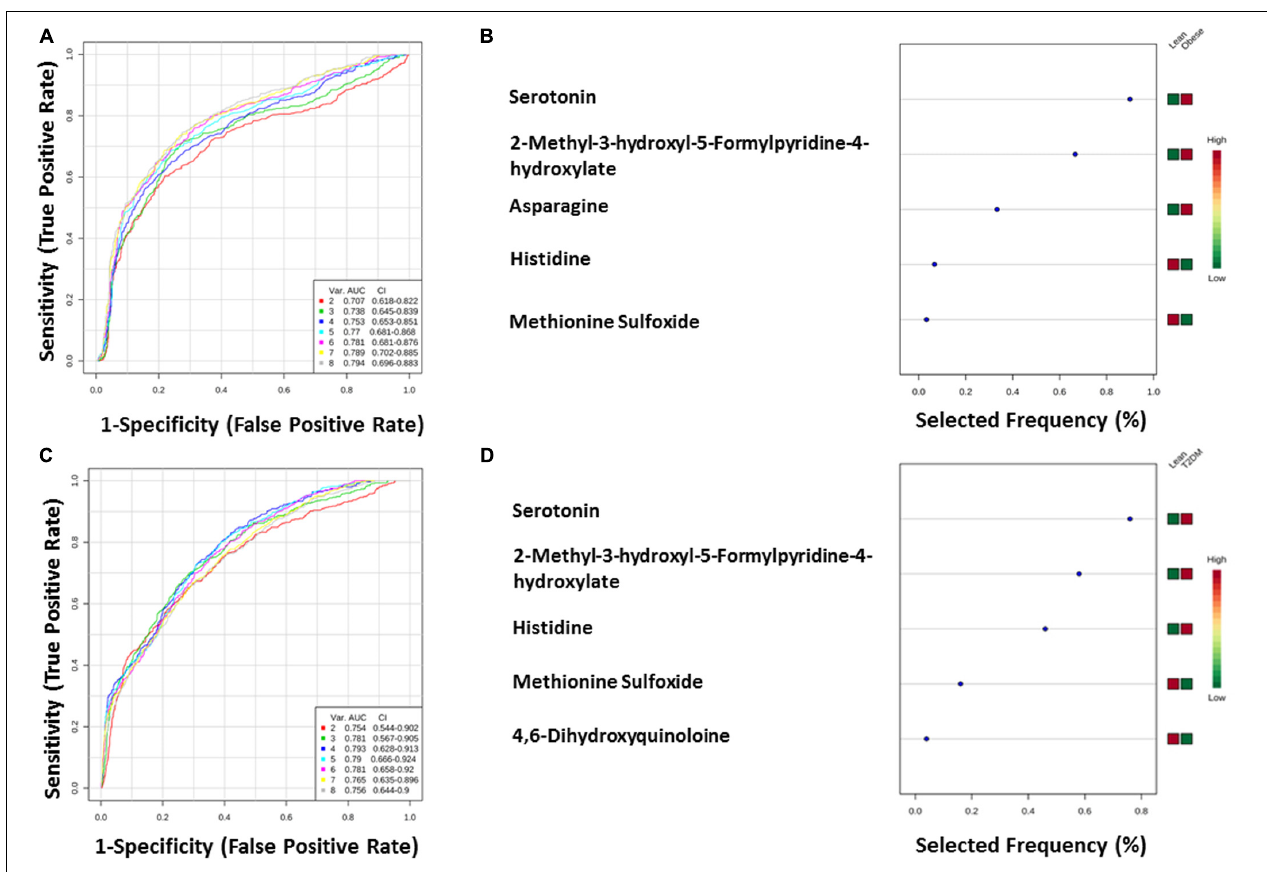
FIGURE 6 | (A,B) Lean vs obese ROC analysis for IR top five metabolites. (C,D) Lean vs